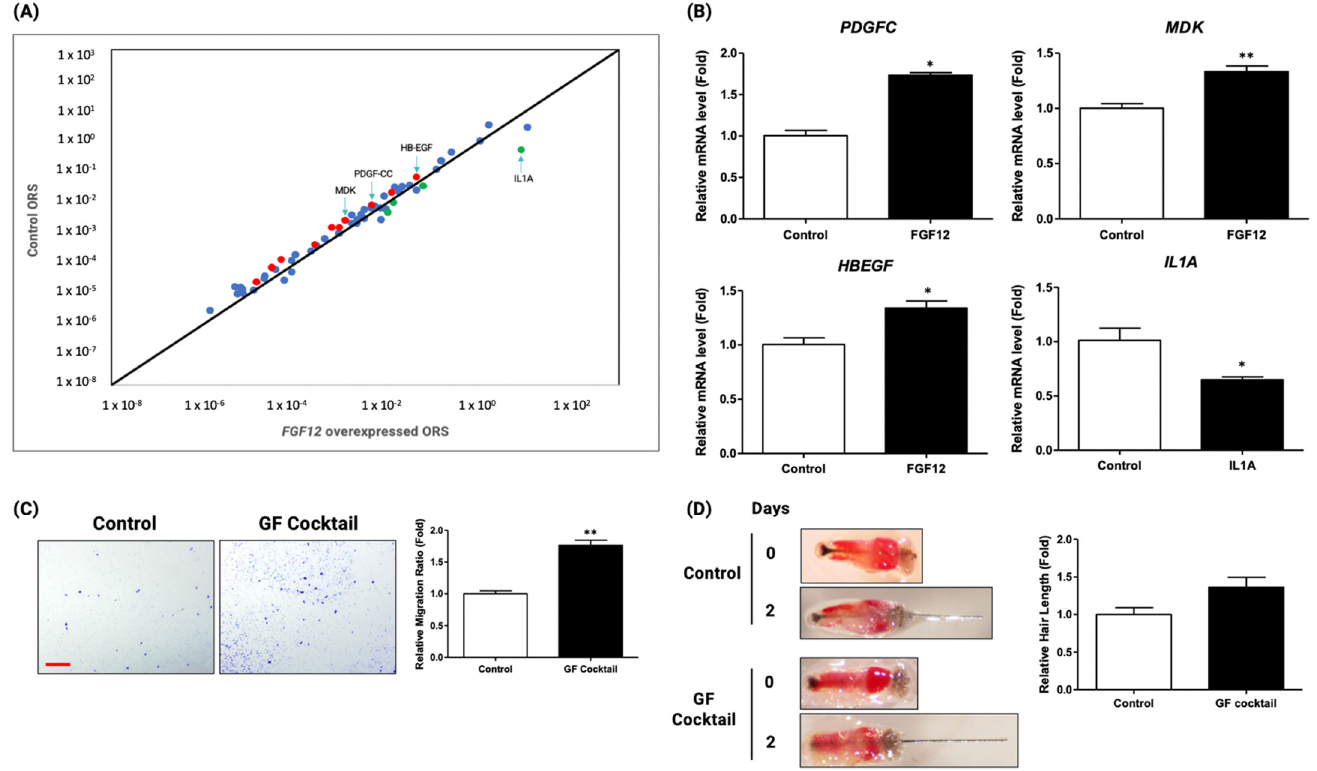
Figure 6. Overexpression of FGF12 in ORS cells upregulated various growth factors and exhibited the potential for a hair growth-promoting effect. ( A ) A scatter plot of RT2 profiler human growth factor PCR array of FGF12 overexpressed HORS cell is shown; n = 3. Red dots indicate genes that are related to hair growth and upregulated >2-fold. Green dots indicate genes that are related to hair loss. Blue dots include genes that are not related to hair growth. ( B ) Upregulation of various growth factors by FGF12 overexpression was confirmed through qRT-PCR; n = 3. ( C ) The growth factor cocktail was treated to ORS cells. The migration has increased by GF cocktail treatment and the quantification of the migration rate is shown; n = 3, scale bar = 50 μ m. ( D ) Organ culture with GF treatment showed that hair fiber with growth factors slightly grew longer than the control group; x1.5 magnification. All data expressed as mean ± standard error (* p < 0.05, ** p < 0.01 versus the control group).